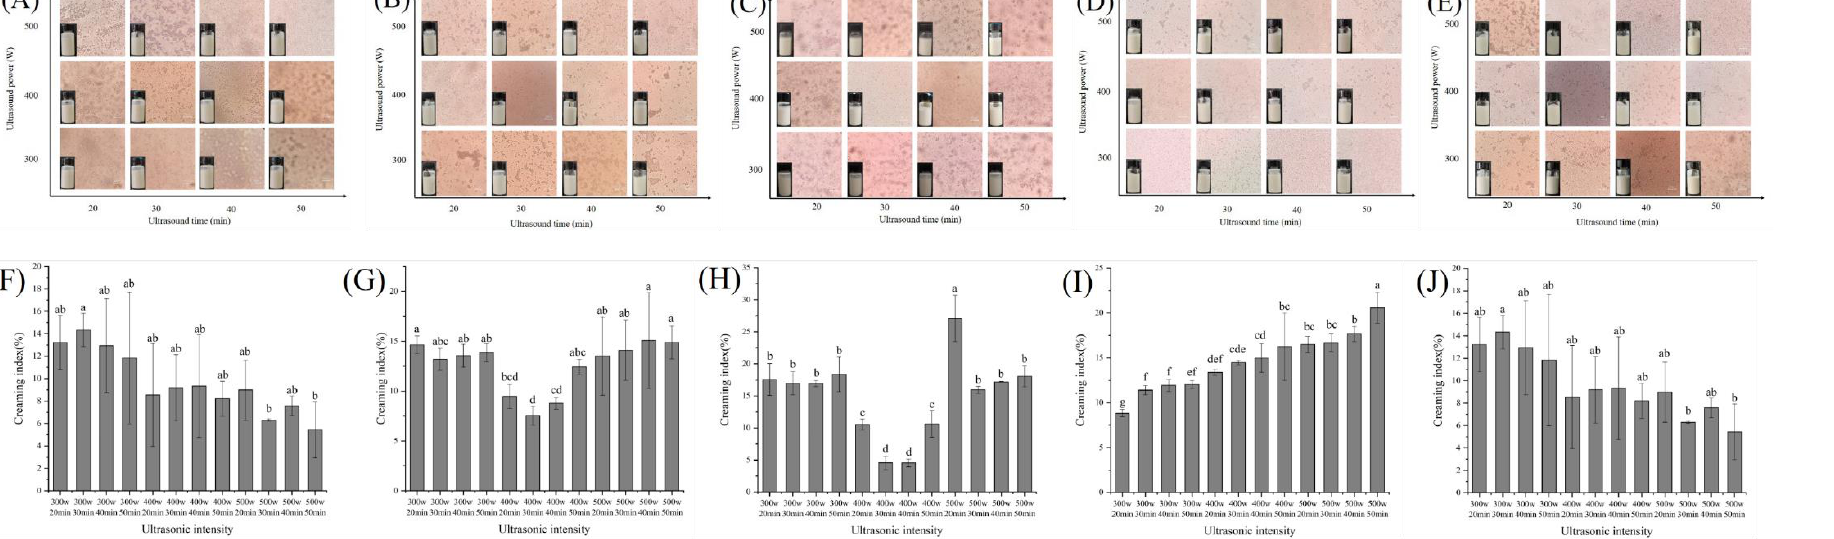
Figure 2. Effects of ultrasonic intensity on microstructure for stored 0 d of RBPE prepared from RB with different storage times (( A ) — 0 d, ( B ) — 1 d, ( C ) — 3 d, ( D ) — 5 d, ( E ) — 10 d) and effects of ultrasonic intensity on CI for stored 7 d of RBPE prepared from RB with different storage times (( F ) — 0 d, ( G ) — 1 d, ( H ) — 3 d, ( I ) — 5 d, ( J ) — 10 d). The different lowercase letters within a column indicate significant differences ( p < 0.05).